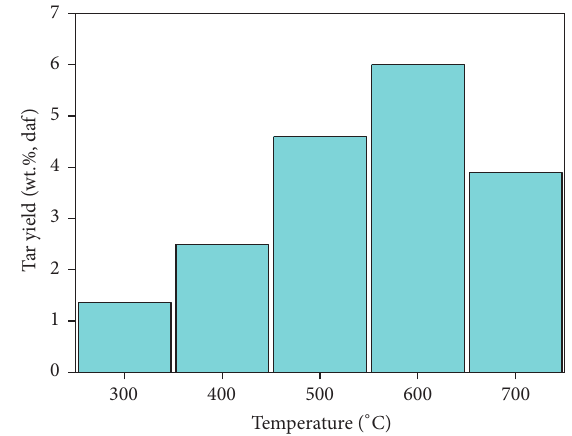
Figure 2: Tar yield based on temperatures without